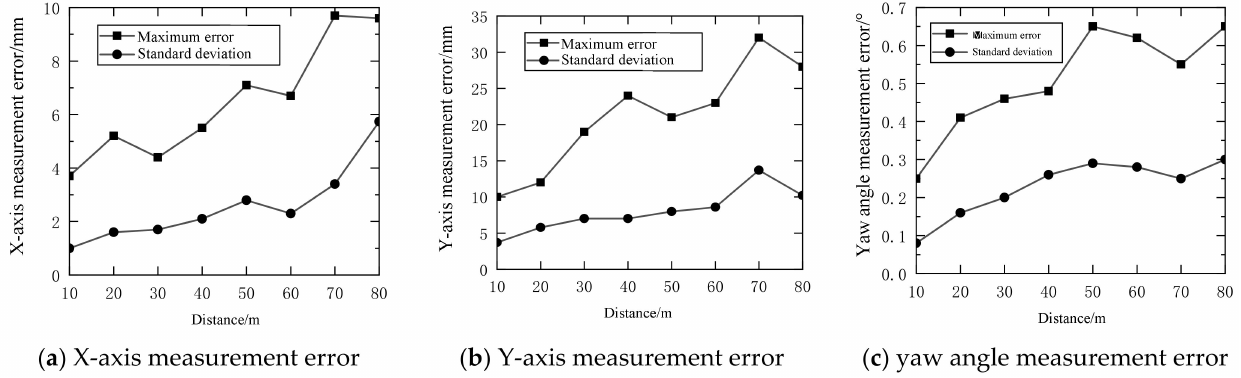
Figure 15. The measurement error of the pose